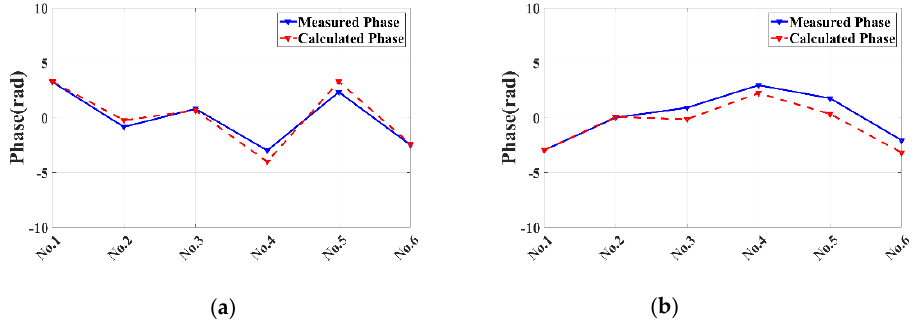
Figure 9. Comparison of theoretical value and experimental data from both two CRs: ( a ) CR 1 ; ( b ) ( b ) CR 2 . CR 2 .